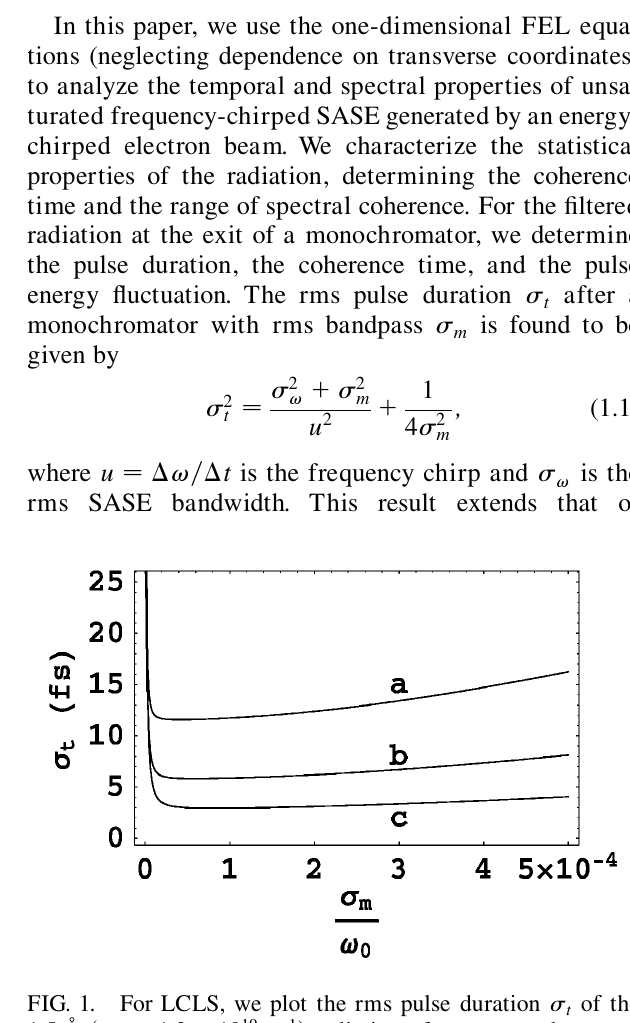
of the t (cid:1) =! ! 0